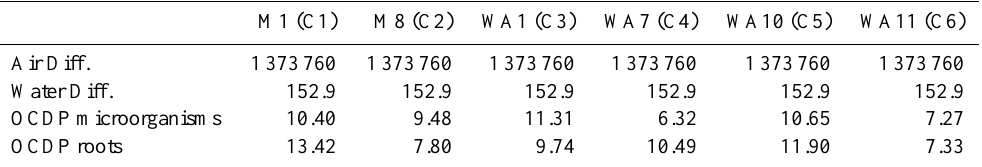
Table 4. Pearson correlations between parameters of the modified Fang et al. (1998) model (Eq. 4). Correlations are underlined while values in italic are the significance of the correlations under alpha = 0.05. Values in bold highlight correlations with significance < 0.05. Variables k 0 1E α a b c d k 0 0.982 − 0.241 0.976 − 0.023 0.980 − 0.042 1E 0.982 − 0.330 0.975 − 0.078 0.977 − 0.102 α − 0.241 − 0.330 − 0.211 − 0.203 − 0.219 − 0.212 a 0.976 0.975 − 0.211 − 0.238 0.999 − 0.256 b − 0.023 − 0.078 − 0.203 − 0.238 − 0.220 0.998 c 0.980 0.977 − 0.219 − 0.042